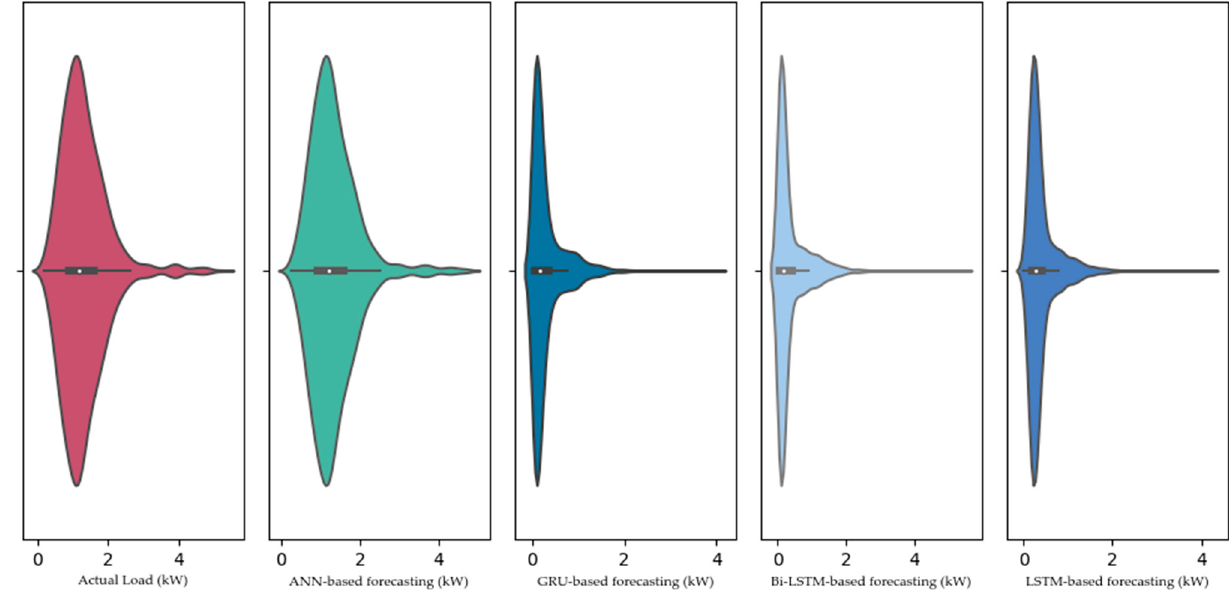
Figure 9. Violin Plot for each model.